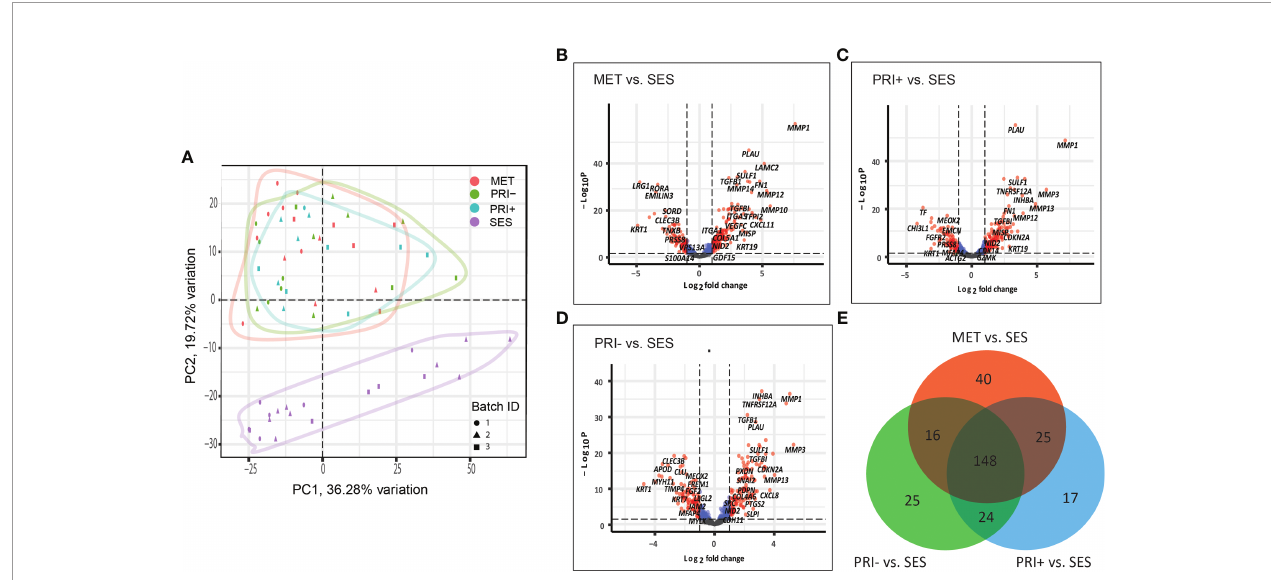
FIGURE 1 | Cancer progression gene expression patterns of sun-exposed skin (SES) and non-metastatic (PRI-) and metastatic (PRI+ and MET) cSCC. (A) Principle component plot of tumor cohorts and SES normalized gene expression data. The fi rst and second principal components are plotted on the x- and y-axis, respectively. Batch ID symbols indicate different NanoString runs and show lack of batch effect. (B – D) Volcano plots illustrating gene expression differences (x-axis) and signi fi cance (y-axis) (dotted horizontal lines) of (B) MET vs. SES, (C) PRI+ vs. SES, and (D) PRI- vs. SES. Each dot represents a gene. (E) Venn diagram depicting DEGs with log2 fold changes of ≥ 1 or ≤ -1 between MET vs. SES, PRI+ vs. SES, and PRI- vs. SES and adjusted p -value ≤ 0.05. The number of DEGs for each pairwise comparison is indicated in the circles of the Venn diagram. The overlap between the circles shows DEGs that occur in more than one